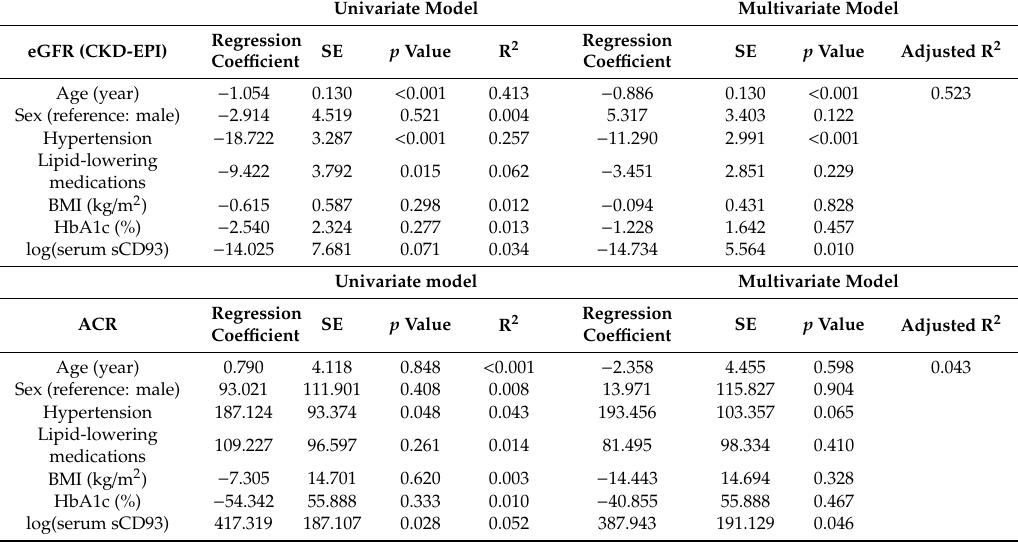
Table 4. Serum sCD93 levels as a determinant of the eGFR and the